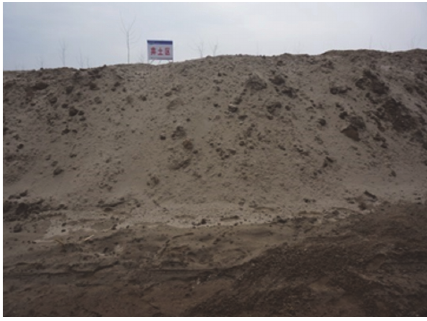
Figure 1: The studied dune sand at the revetment of Yangtze River.